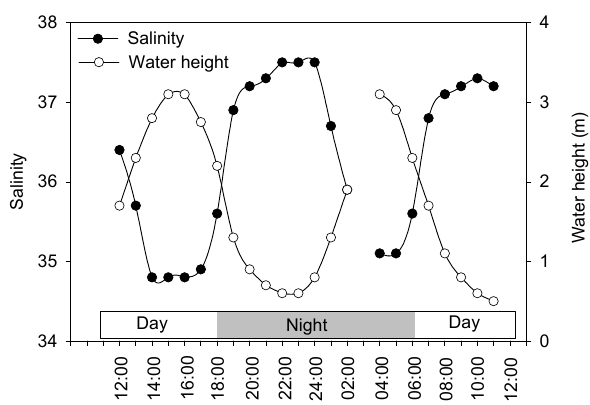
Fig. 2. Tidal variations of salinity in surface waters and water Figure 2